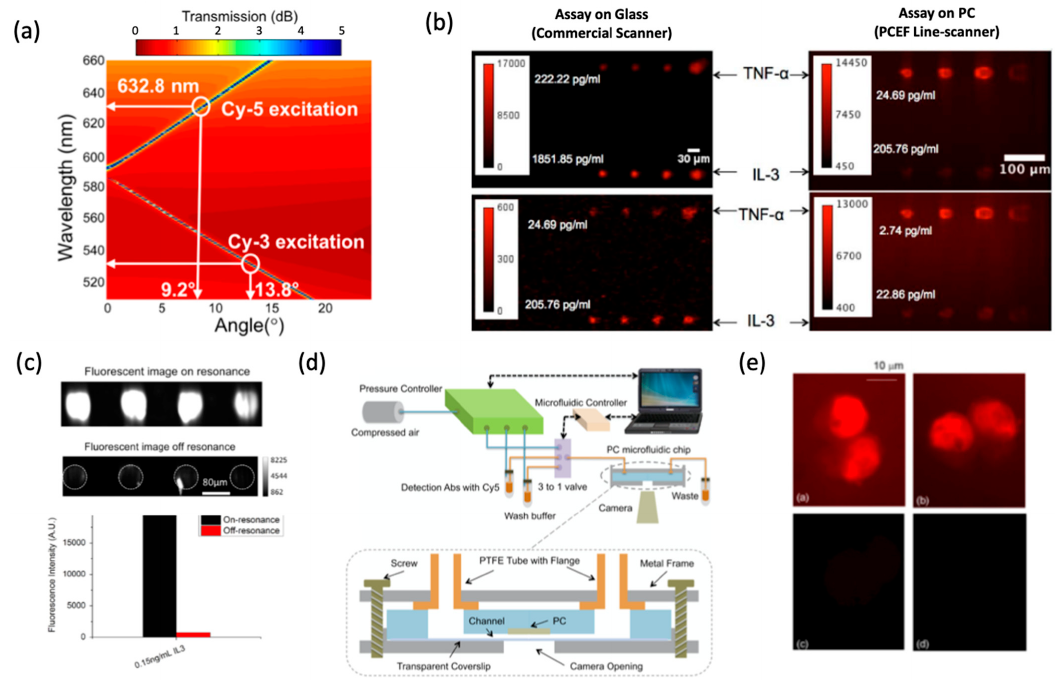
Figure 9. PCEF applications in bio-imaging. ( a ) PC band-diagram design for fluorescent enhance- ment. ( b ) Fluorescent images of micro-spots from the TNF- α and IL-3 sandwich immunoassay [83]. ( c , d ) Integrated microfluidic PCEF scanning system with pg/mL-level limits of detection. Reprinted with permission from Ref. [84] Copyright 2015 Elsevier B.V. ( e ) Fluorescence microscope images of labeled cells on different substrates. Top left: lateral grating plate. Top right: longitudinal grating plate. Bottom left: glass slide with coating. Bottom right: uncoated normal glass slide. Bar corre- sponds to 10 μ m. Reprinted with permission from Ref. [85] Copyright 2015 The Optical Society.